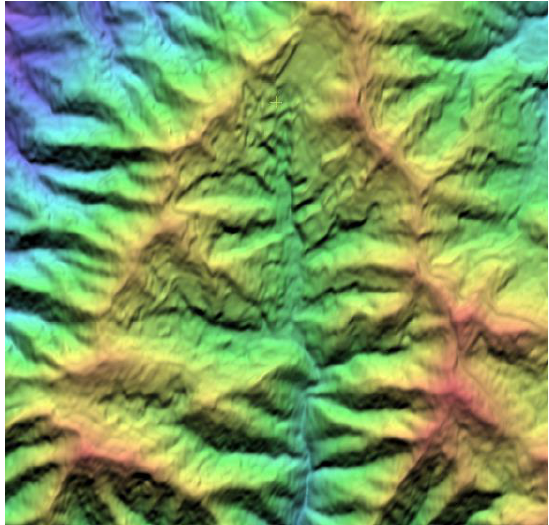
Figure 5. A sample from the backward-nadir DSM